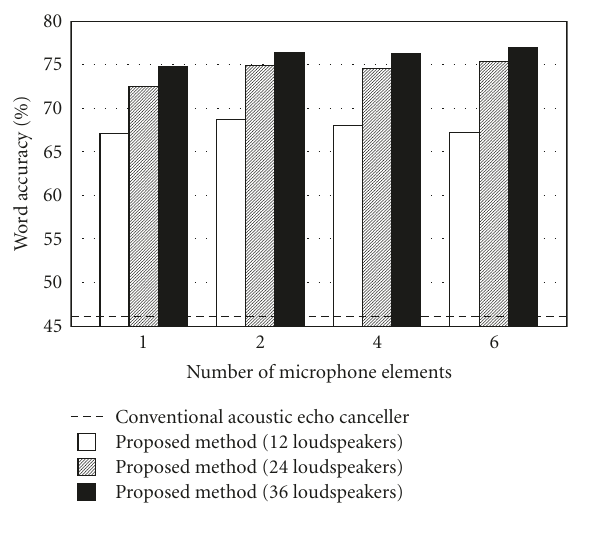
Figure 11: Word accuracy with clean model.